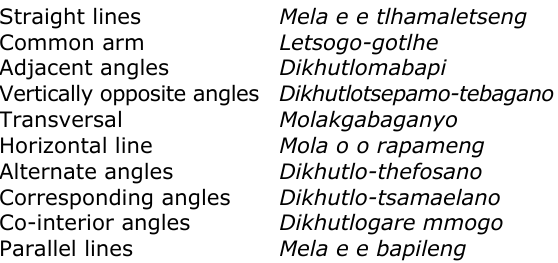
Figure 3: An example of notes in two